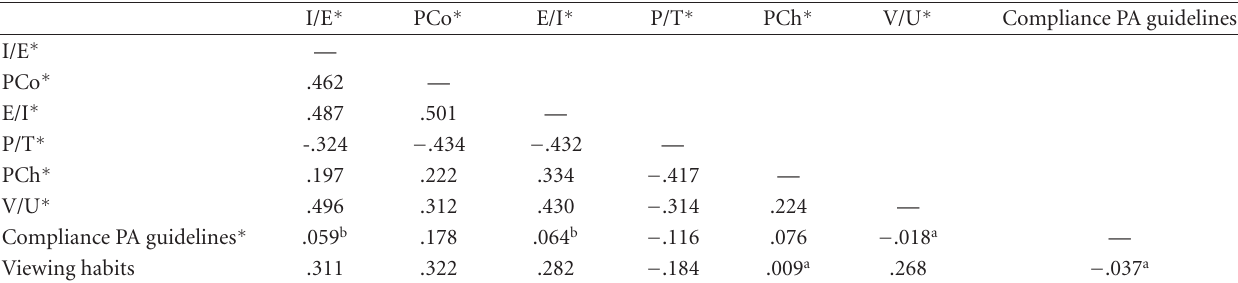
Table 2: Correlation matrix for the six IMI subscales, compliance with the physical activity guidelines, and viewing habits.